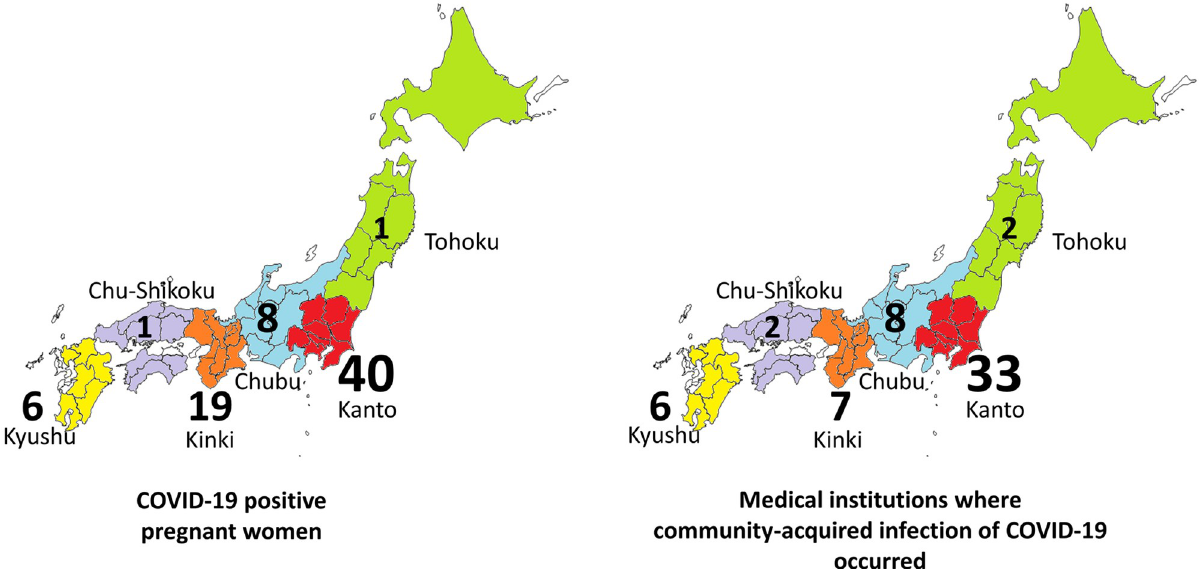
Fig 3. Geographical distribution of pregnant women with COVID-19, and medical facilities where community-acquired infection of COVID-19 occurred in Japan (-2020 June).